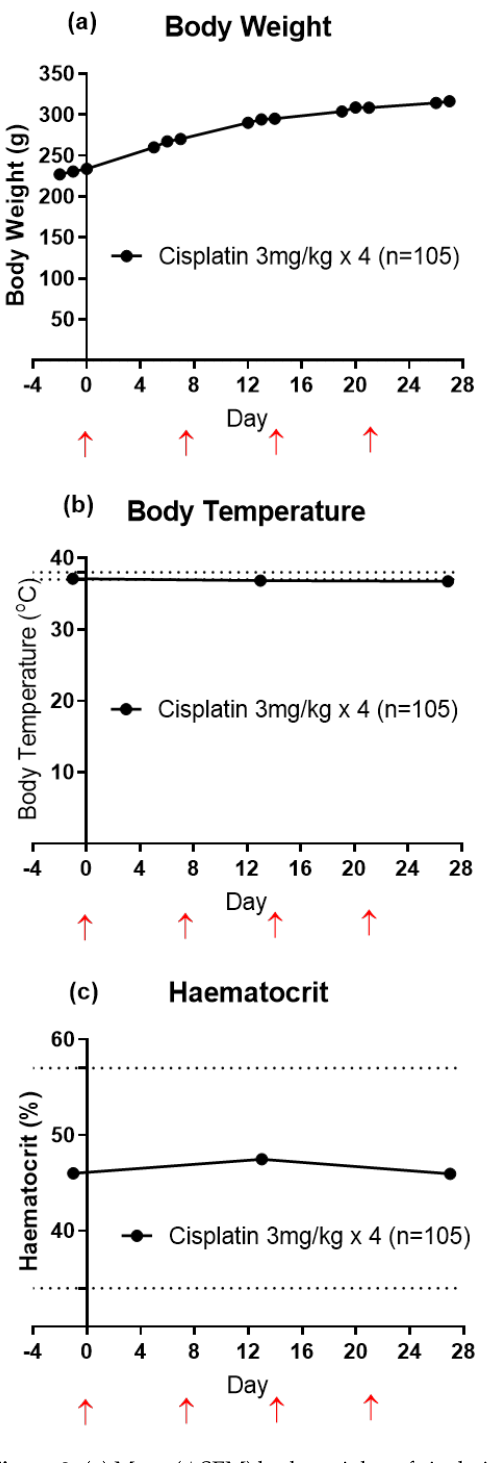
Figure 2. ( a ) Mean ( ± SEM) body weights of cisplatin-induced CIPN-rats commencing on day − 2 and continuing for the 27 day study duration. ( b ) Mean ( ± SEM) body temperature of cisplatin-treated Sprague-Dawley rats from day − 1 to 27. The normal body temperature range for rats (horizontally dotted lines) is 37 to 38 ◦ C. ( c ) Mean ( ± SEM) blood haematocrit levels in cisplatin-induced CIPN-rats from day − 1 to day 27. The normal haematocrit range for rats (horizontally dotted lines) is 34% to 57%. Red upward pointing arrows indicate the days of each cisplatin (3 mg/kg; IP) injection. Please note that the error bars have been added, but they cannot be seen as the data is very tight (n = 105).